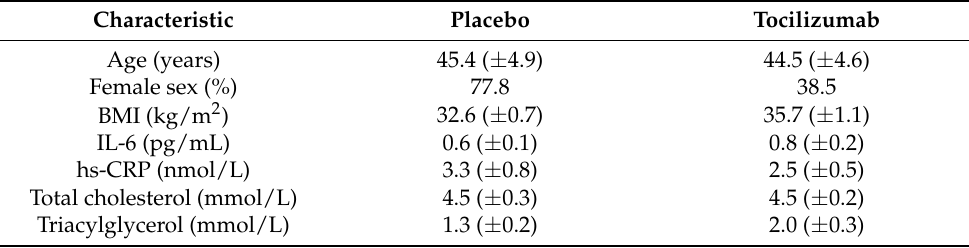
Table 1. Baseline